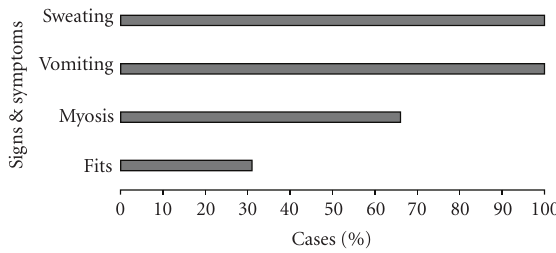
Figure 3: Frequency of signs and symptoms among patients with organophosphorous poisoning, Sindhikela, Bolangir, Orissa, India,